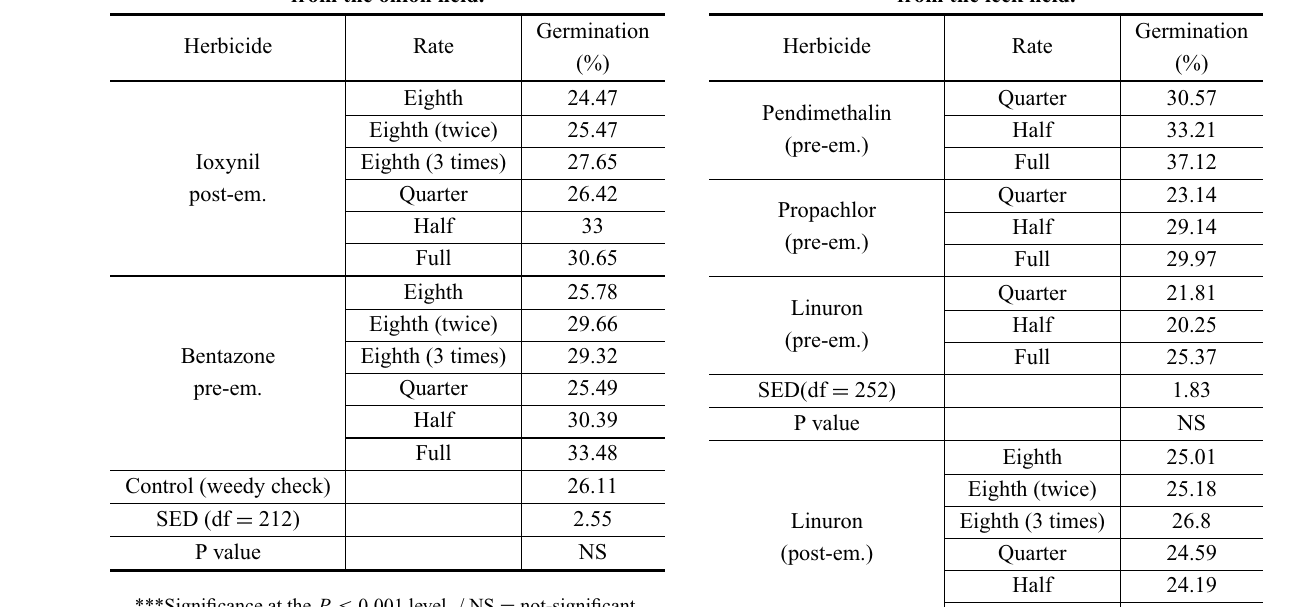
Effects of pre and post-emergence herbicides on the germination (%) of the C. album seed progeny collected from the leek